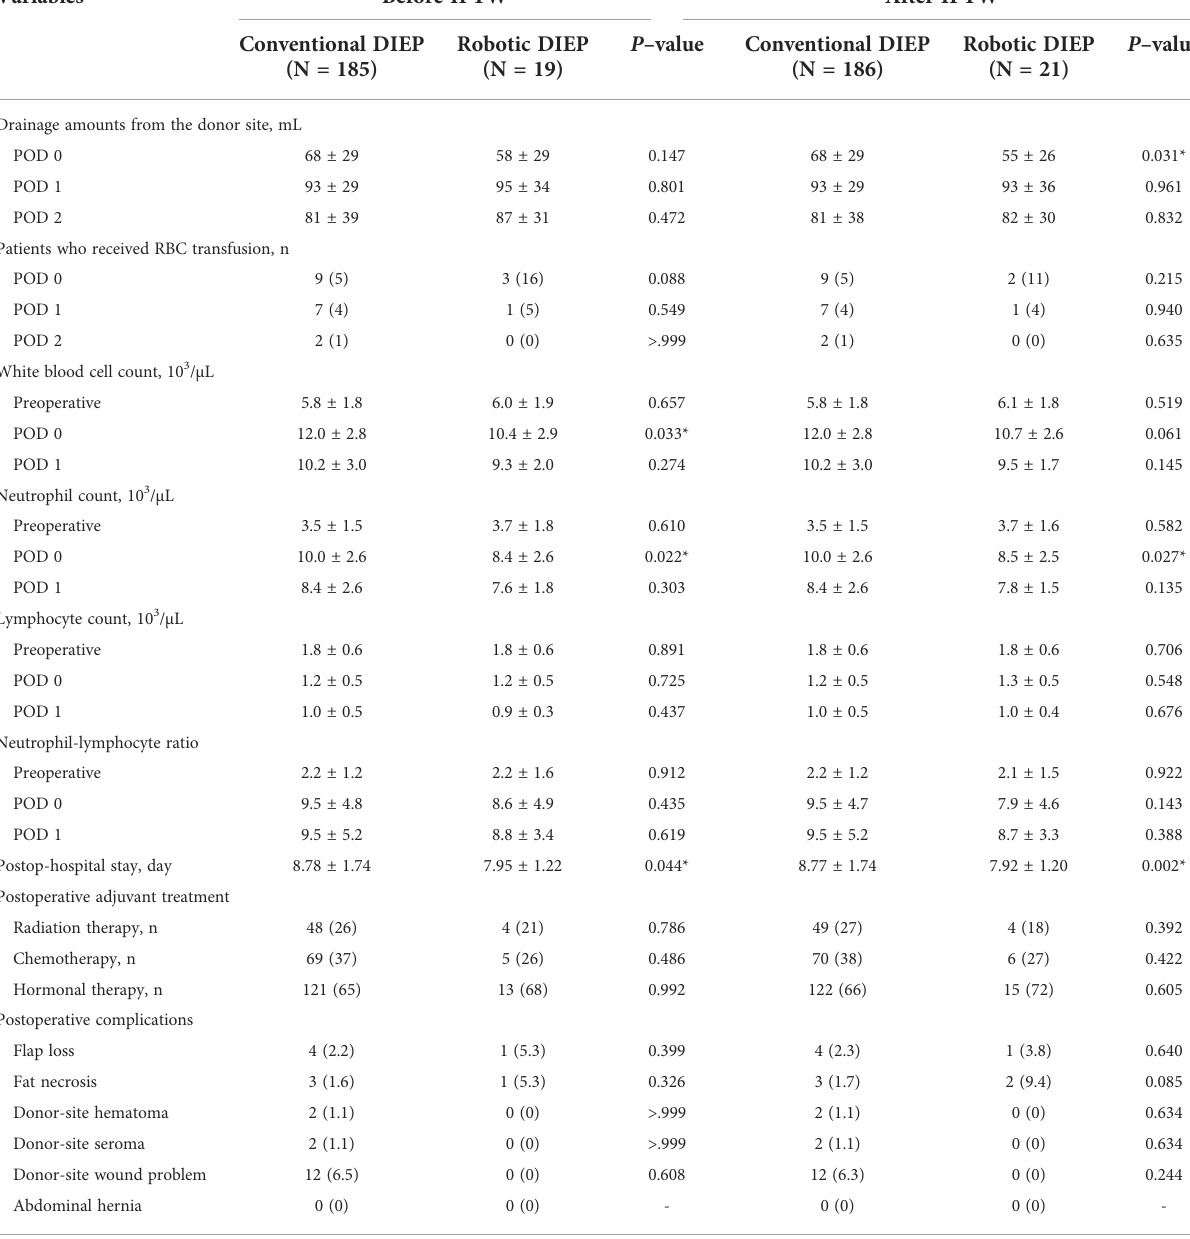
TABLE 3 Postoperative variables and laboratory